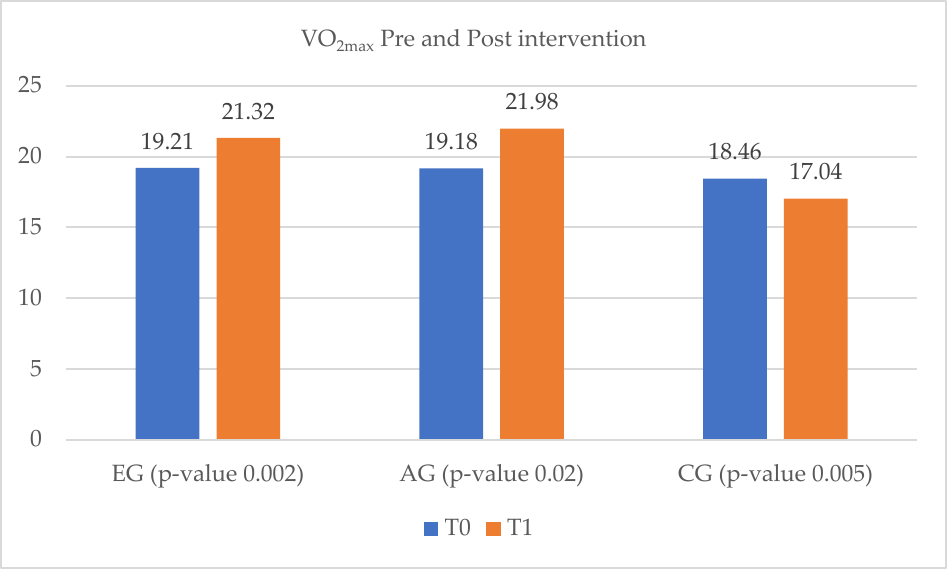
Figure 1. Values of VO 2max pre- and post-intervention. VO 2max = maximal oxygen consumption by the body (measured in mL/kg/min); EG = experimental group; AG = ambulatory group; CG = control group; T 0 = before the rehabilitation period; T 1 = after the rehabilitation period.